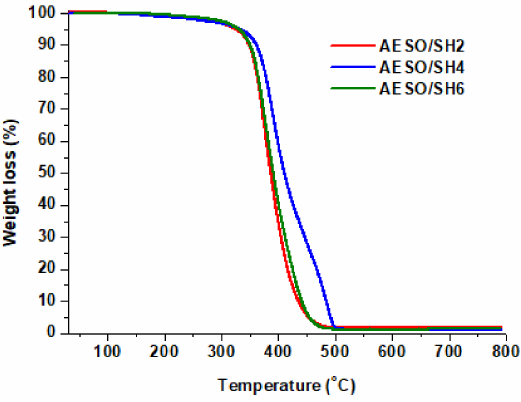
Figure 5. Thermogravimetric curves of polymers cross-linked with different